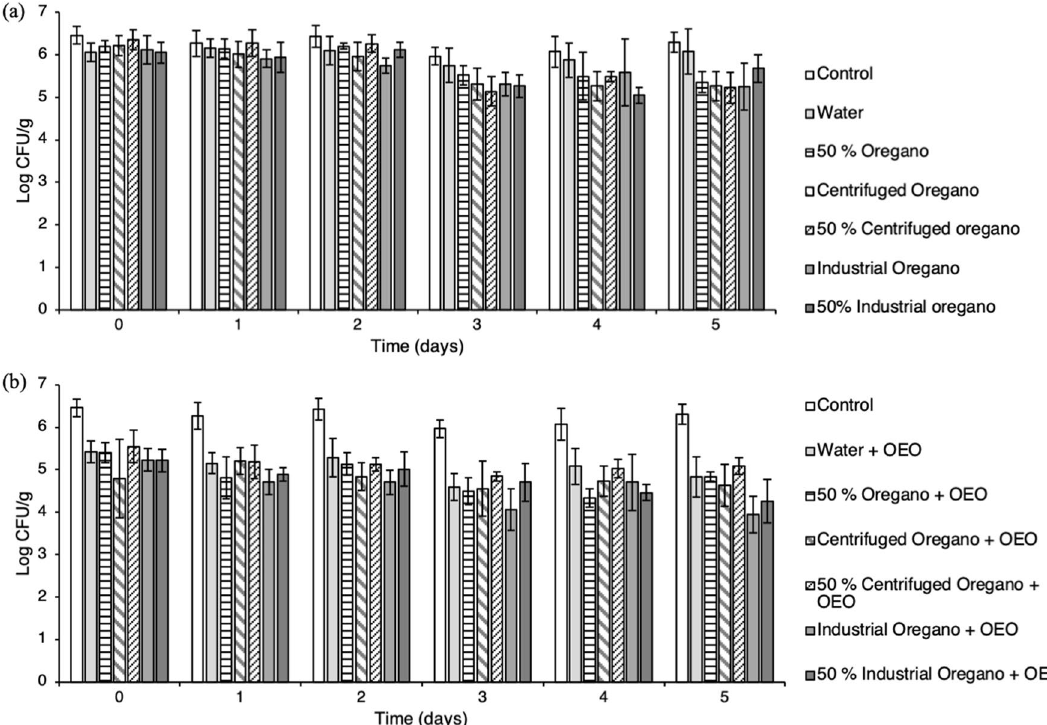
Figure 4. Effect of edible coatings prepared of water, hydro-distilled oregano extract and industrial oregano hydrolate supplemented without ( a ) or with ( b ) 0.5% oregano essential oil (OEO) on the survival of S. Typhimurium FS8 inoculated in pork meat at 4 °C. Inoculated uncoated pork meat samples were used as controls. Sampling was performed immediately after treatment and up to 5 days of storage. Each bar represents an average (± standard deviation) of six